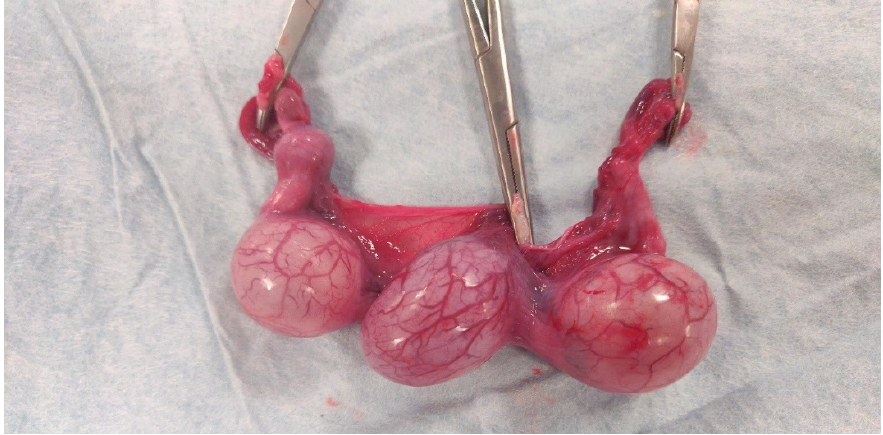
Figure 2. Uterus after ovariohysterectomy. Three different embryonic vesicles can be seen.